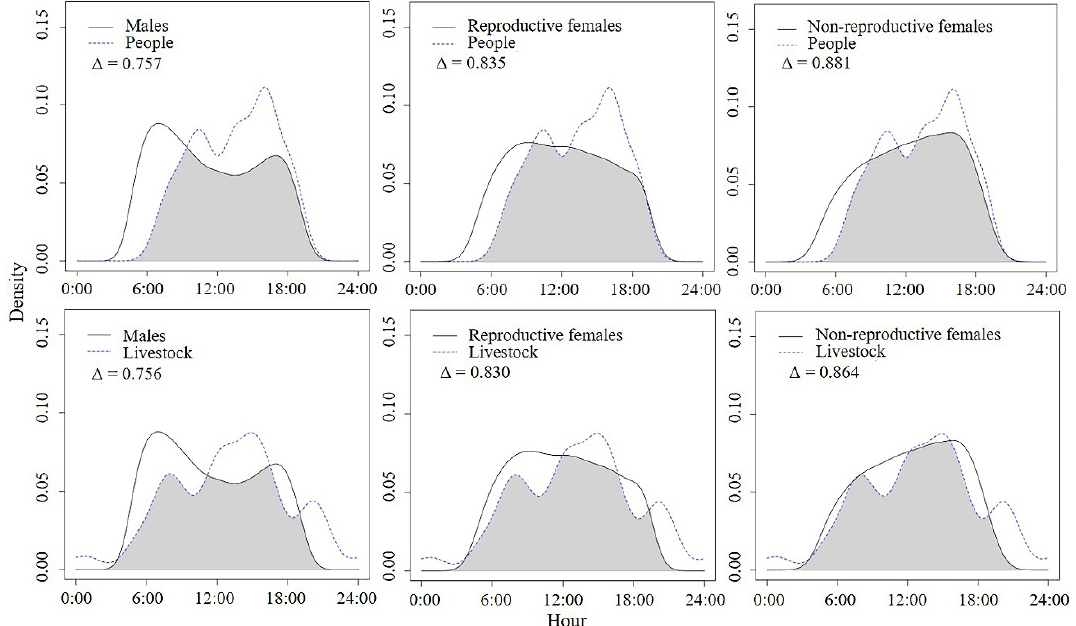
Figure 2. Relationships between diel movement patterns of Reeves’s Pheasants and human presence during the breeding season.